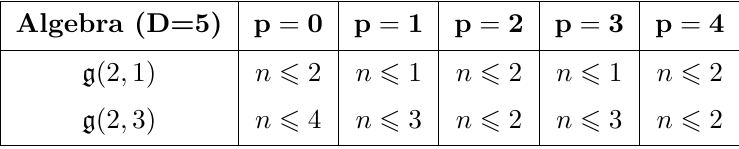
( n ) B under the algebras g (2 ; 1) and g (2 ;